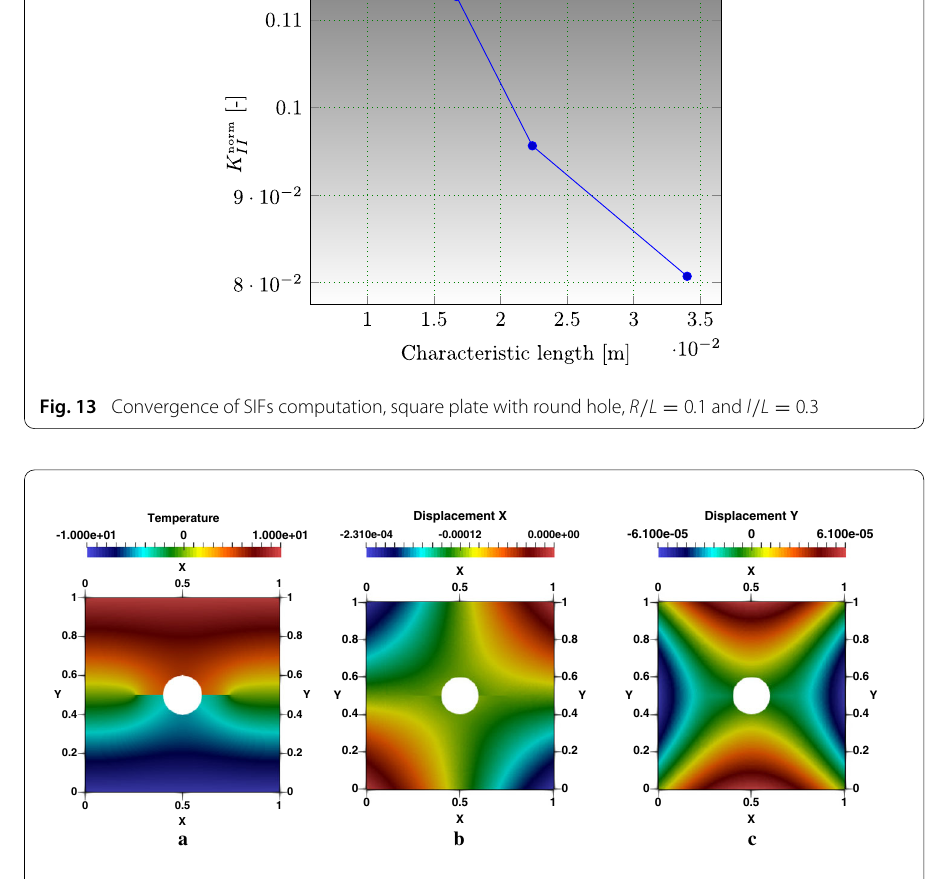
Fig. 14 Square plate with round hole, R / L = 0 . 2, l / L = 0 . 3: a temperature, b e x -displacement, c e y